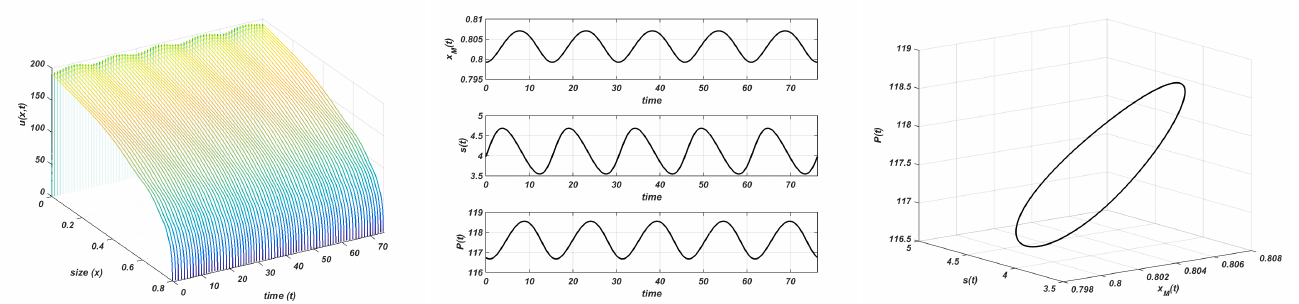
Figure 8. Gompertz growth. r = 3 and K = 14.73. Stable limit cycle. Plot on the left : evolution of the structure of the consumer; plot in the centre : evolution of the maximum size, resource, and total consumer population to the equilibrium; plot on the right : stable limit